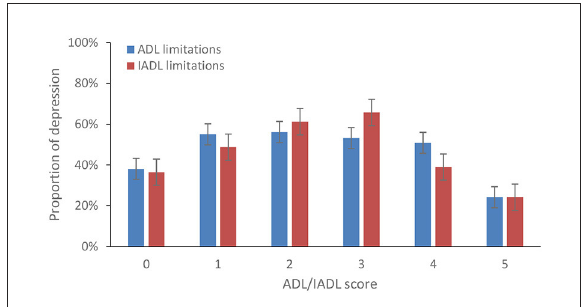
FIGURE1 Percentage of depressive symptoms among patients with stroke by the score of functional limitations, 2018.